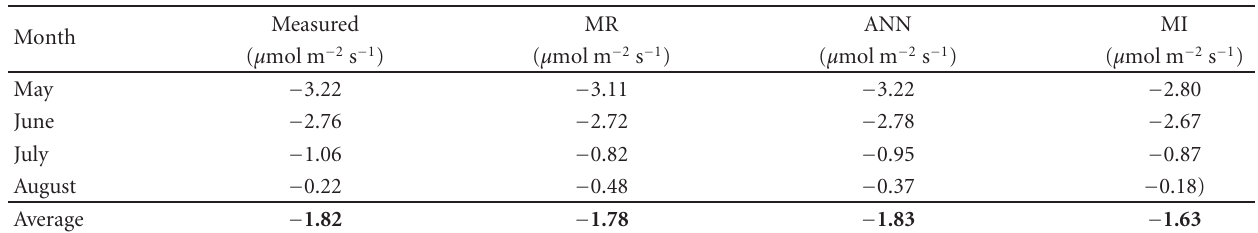
Table 4: Monthly averages of the measured CO 2 flux and of the CO 2 flux gap filled MR, ANN, MI for warm season.